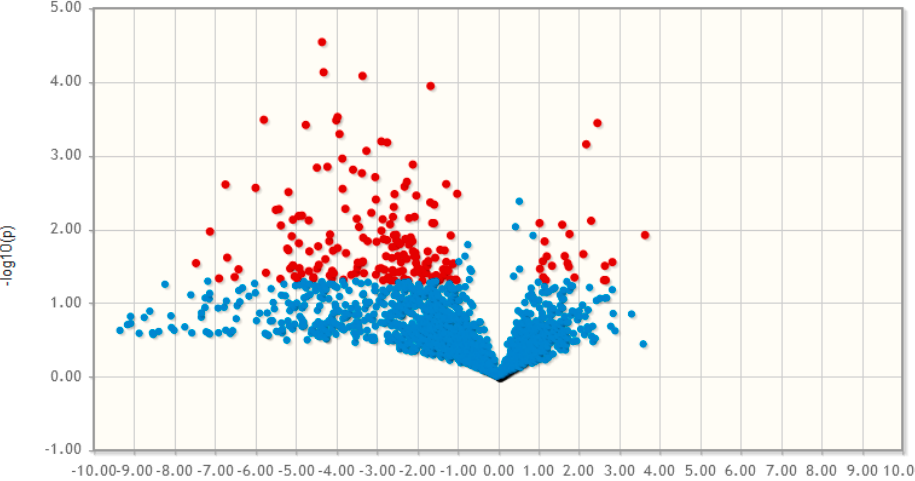
Figure 3. Di ff erential analysis of lipids and metabolites. Volcano plot (derived from untargeted LC-MS) of compounds from primary MSCs and adipocytes using MetaboAnalyst 4.0 (with p -value settings 0.05, interquartile filter) [32]. HILIC-RP-HRMS (positive mode) revealed that 195 out of 3498 compounds were significantly regulated ( p -value < 0.05, fold change (FC) > 2). Both lipids and metabolites were significantly upregulated in adipocytes compared to MSCs.